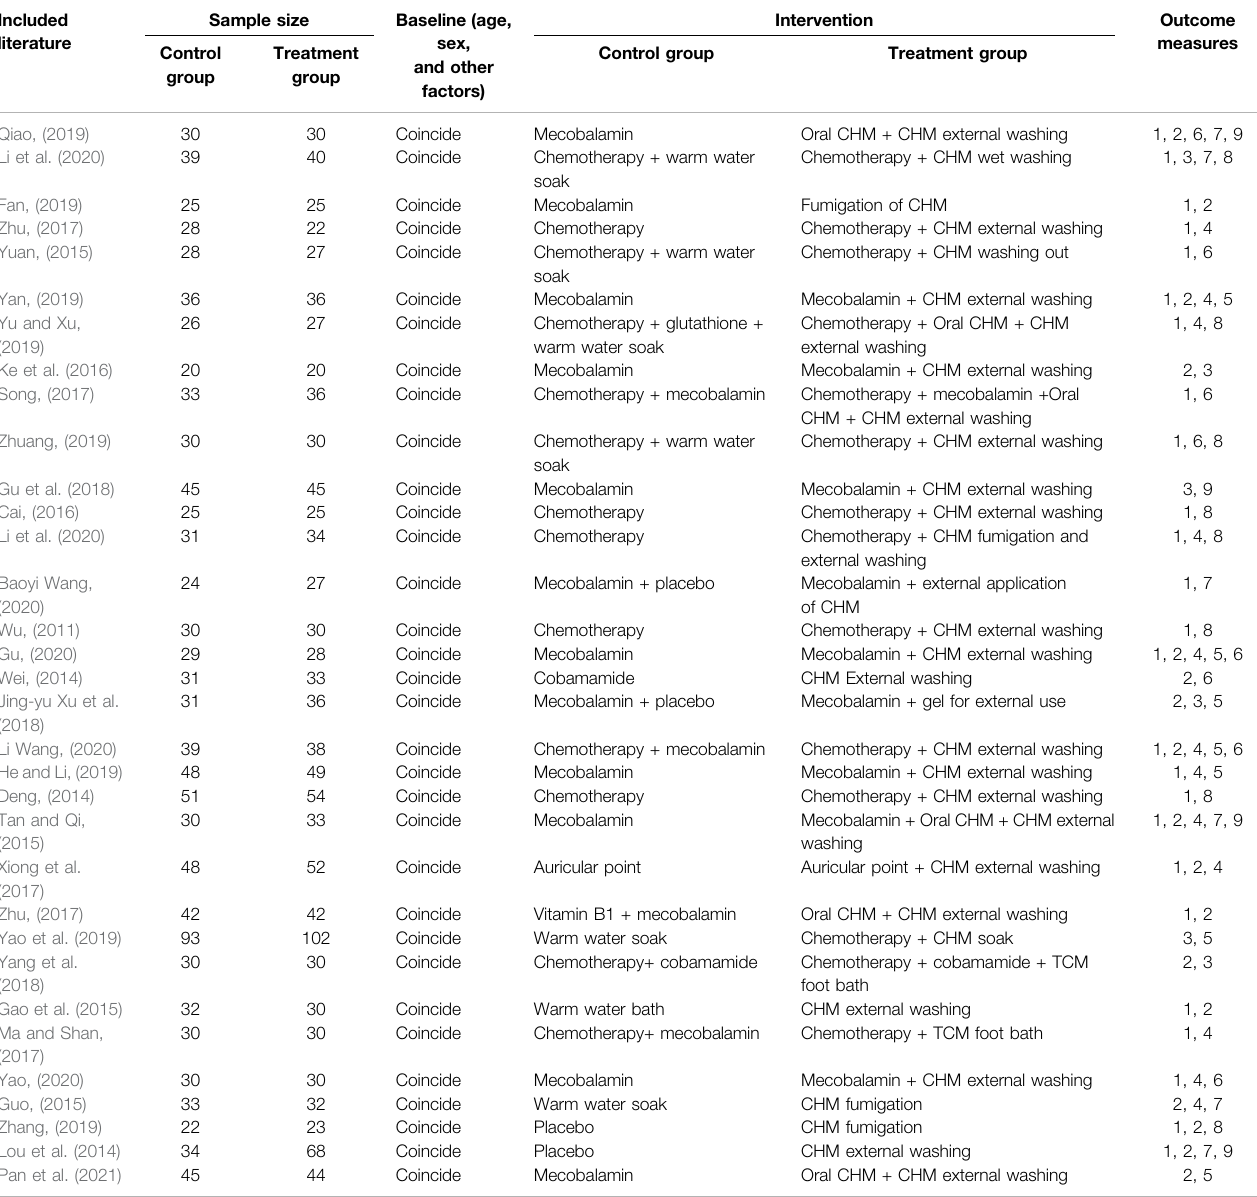
TABLE 1 | Basic information about the included